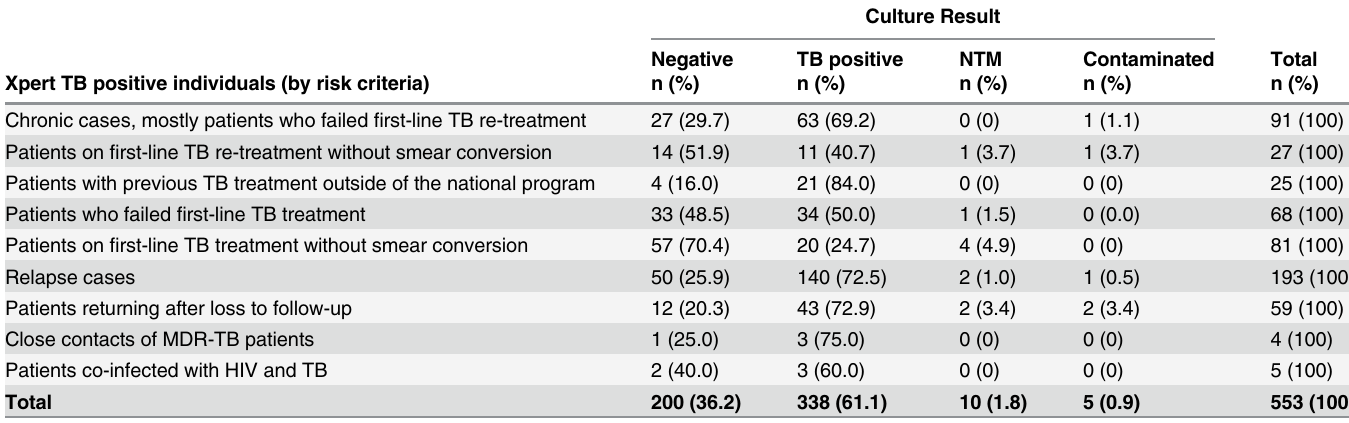
Table 4. Follow-on culture results among individuals from various risk groups that tested Xpert MTB/RIF TB positive in three provincial hospitals in Java, Indonesia.